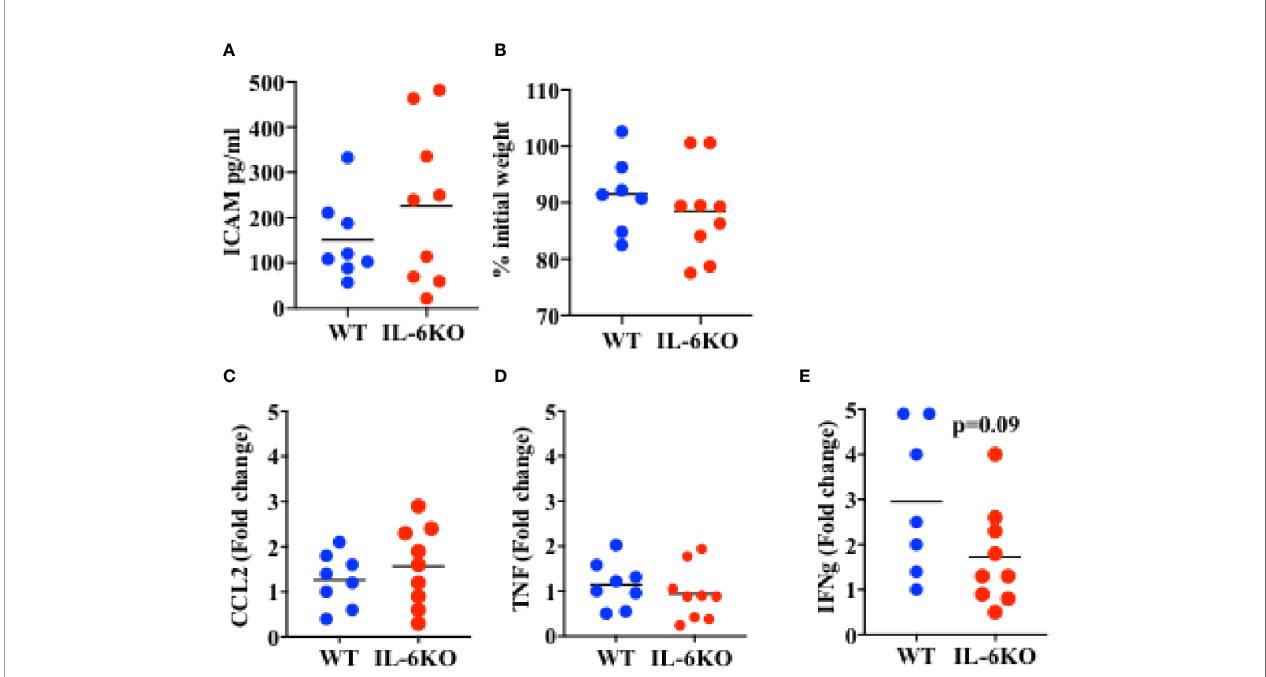
FIGURE 5 | Response to a lethal dose of in fl uenza in i.n. immunized WT and IL-6KO mice. Mice received intranasal immunization with inactive virus on day 14 of life. Three weeks later, mice were weighed and given a lethal dose PR8 virus. Six days after challenge mice were euthanized and tissues harvested for analysis. (A) Serum ICAM was analyzed by Luminex ™ . (B) Weight of mice, 6 days post-infection. Shown is the % relative to the initial weight prior to infection. (C – E) Whole lung relative mRNA expression for CCL2 (C) , TNF (D) and IFNg (E) determined by real time RT-PCR. Values show fold induction relative to a WT. Each dot represents a mouse. One experiment is shown. Bars indicate mean for group. Comparison utilized the t test, with signi fi cance set at p <